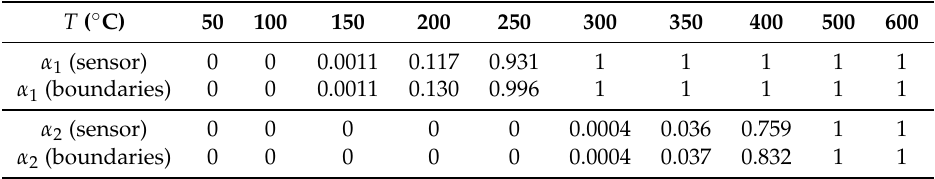
Table 4. Advancements α 1 and α 2 when Λ ⊥ was recorded in the “direct” simulation, at the sensor position and at the outer boundaries of the